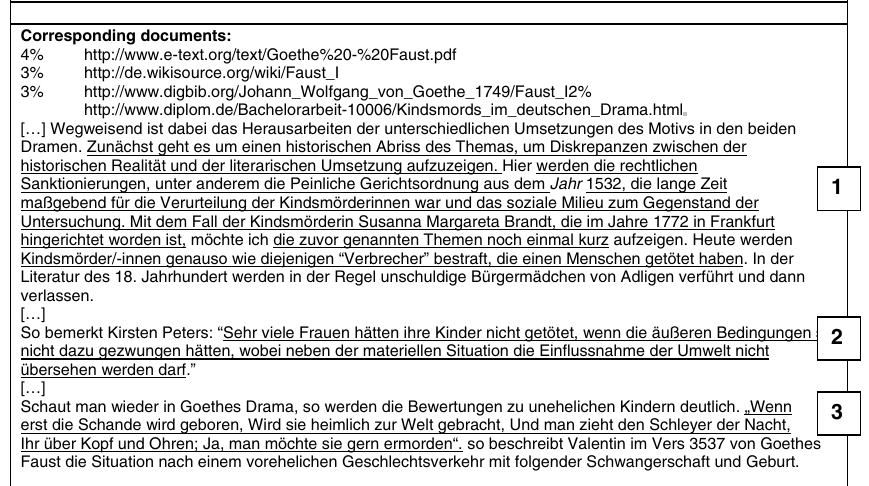
Figure 5. Printable result of plagiarism detection via PDS